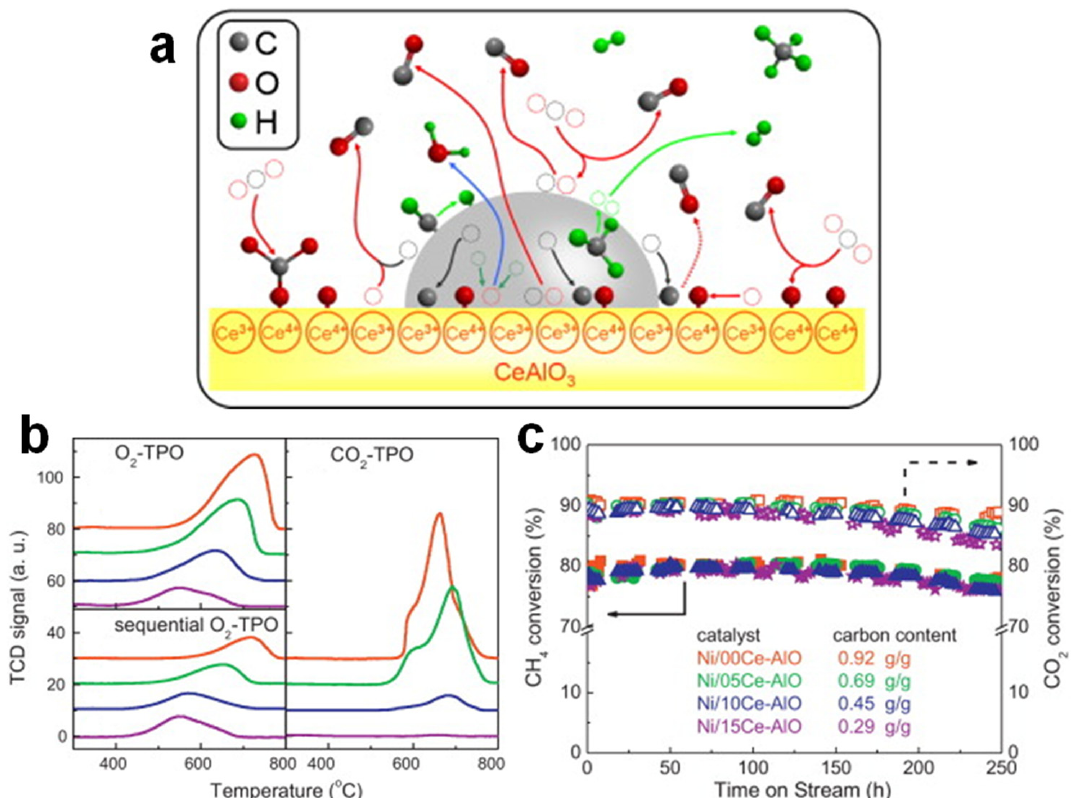
Figure 6. ( a ) Schematic representation of reaction and carbon deposition over Ni/Ce–AlO catalysts. ( b ) O 2 -TPO, sequential CO 2 -TPO and O 2 -TPO profiles of the catalysts after 250 h DRM tests at 800 ◦ C: Ni/00Ce–AlO (red), Ni/05Ce–AlO (green), Ni/10Ce–AlO (blue) and Ni/15Ce–AlO (purple). ( c ) Activity performance and carbon content of the catalysts in 250 h long-term tests. Reaction conditions: 800 ◦ C, GHSV = 20,000 mL min − 1 g − 1 , atmospheric pressure. Square: Ni/00Ce–AlO; circle: Ni/05Ce–AlO; triangle: Ni/10Ce–AlO; star: Ni/15Ce–AlO. Reproduced with permission from [89]. Copyright 2013, Elsevier.